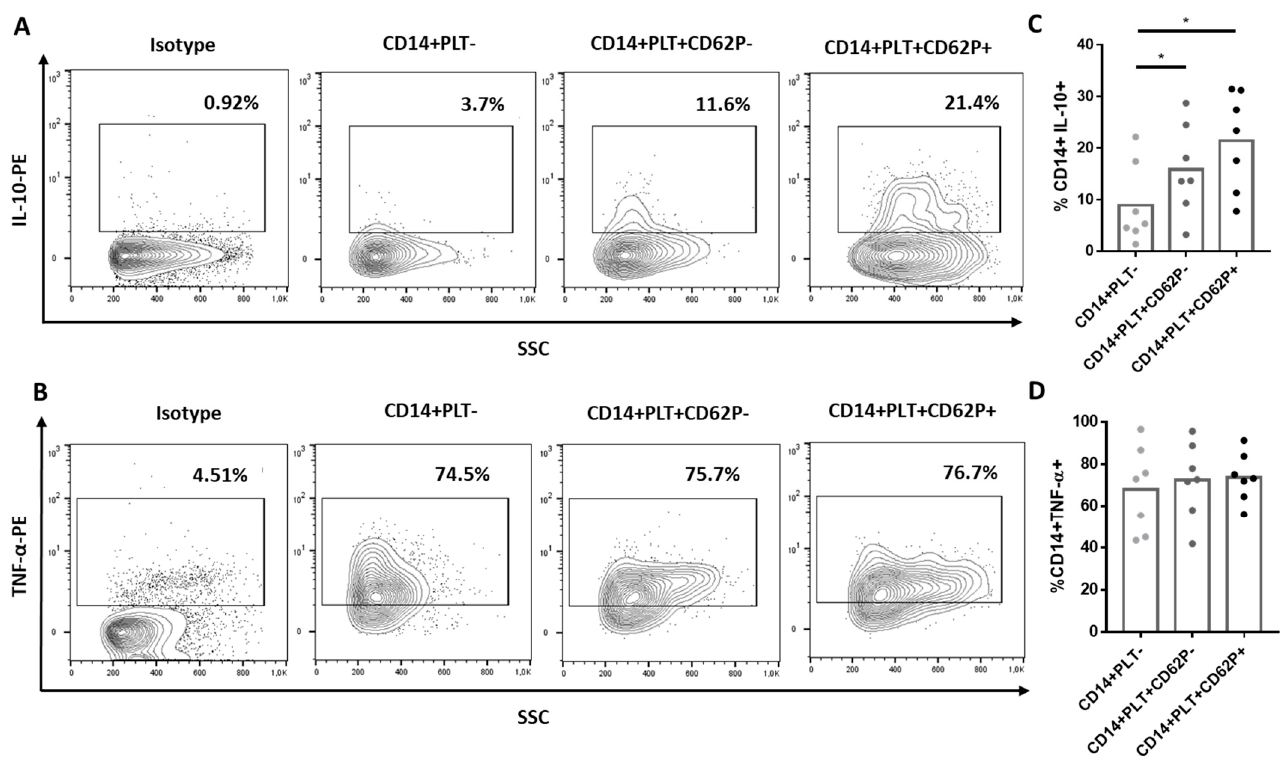
Figure 3. Cytokine production by monocytes without platelets (CD14+PLT-) and with non-activated (CD14+PLT+CD62P-) or activated (CD14+PLT+CD62P+) bound platelets. PBMCs were stimulated with LPS for 4 hours, and the secretion of IL-10 and TNF- α was analyzed by flow cytometry. A representative experiment is shown here ( n = 7). The percentage of ( A ) IL-10+ or ( B ) TNF- α + cells on CD14+PLT-, CD14+PLT+CD62P- or CD14+PLT+CD62P+ is shown. A comparison between percentages of ( C ) IL-10+ or ( D ) TNF- α + cells on CD14+PLT-, CD14+PLT+CD62P- and CD14+PLT+CD62P+ is shown from 7 independent experiments. Statistical analysis was performed using one-way ANOVA with Tukey’s multiple comparisons test. * p < 0.05.